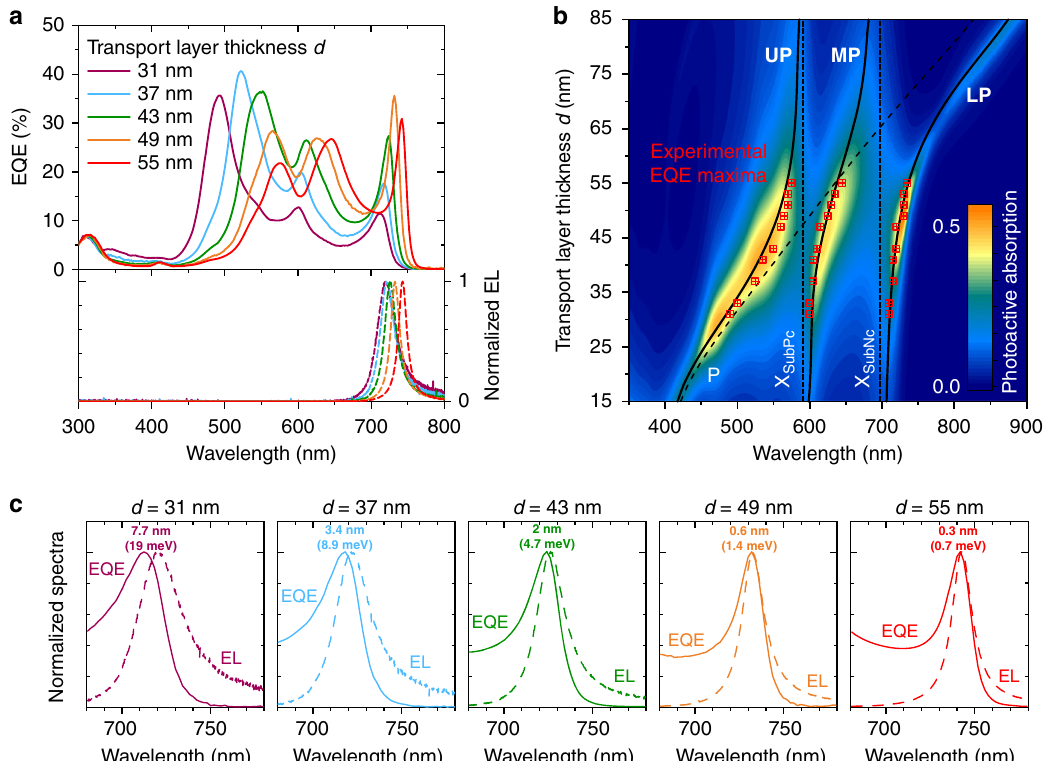
Fig. 2 Thickness-dependent EQE and EL of SubNc/Cl 6 -PhOSubPc-based devices under strong coupling. a EQE (upper panel) and normalized electroluminescence (EL) spectra (lower panel) of fi ve SC-devices, for different transport layers ’ thickness d , showing the redshift of the device ’ s absorption and emission for increasing d . Different values of d lead to different cavity lengths and resonance wavelengths for the cavity photons. The fi ve devices were exemplarily selected for the investigated range d , and the full series of devices is shown in Supplementary Fig. 2. b Simulated photoactive absorption (false color) in cells with varying d showing the formation of polariton branches with pronounced anti-crossing at overlapping points of the cavity and exciton resonances (dashed lines). The simulation results agree well with the calculated polariton branches (solid lines) of a coupled oscillator model and the experimental EQE data (red squares). c Comparison between EQE and EL peaks of the LP peak for various d . The colored numbers (in nm and meV) denote the Stokes shift in each case. The minimal Stokes shifts con fi rm that the investigated devices operate in the strong coupling